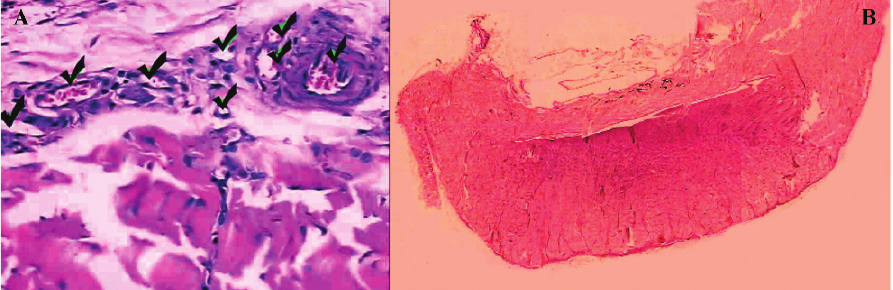
Figure - 1A (left): Histological section of a patellar tendon stained with hematoxylin-eosin (200 6 ). Checkpoint arrows represent identified blood vessels. Figure - 1B (right): Patellar tendon section stained with hematoxylin-eosin (10